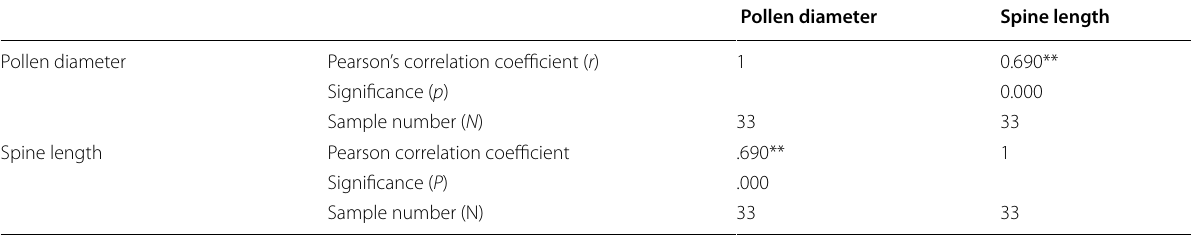
**Represents the correlation reached very significant (P < 0.01)